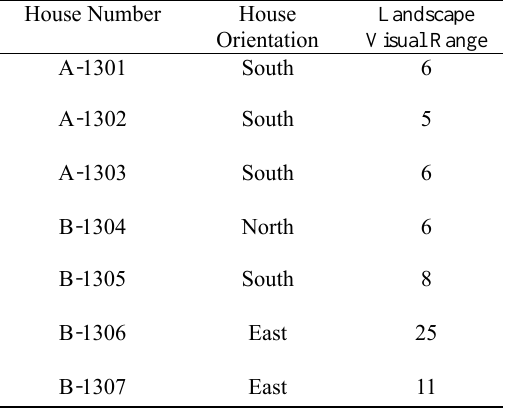
Figure 5. Visualization Effect Chart of Landscape Analysis